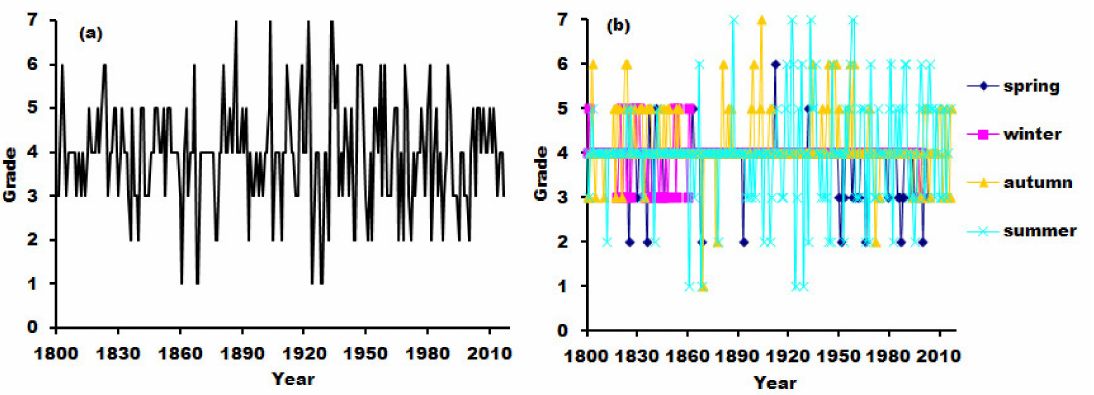
Figure 2. Sequences of droughts and floods in the upper reaches of the Weihe River Basin during 1800 to 2017. ( a ): Year; ( b ): four seasons.